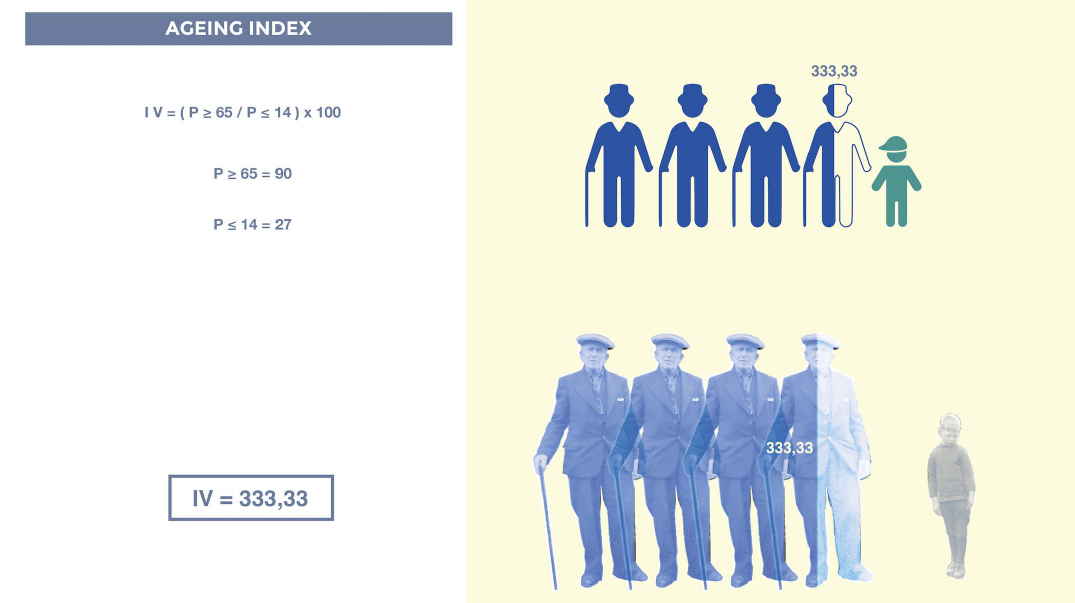
Figure 6. Representing an indicator: ageing